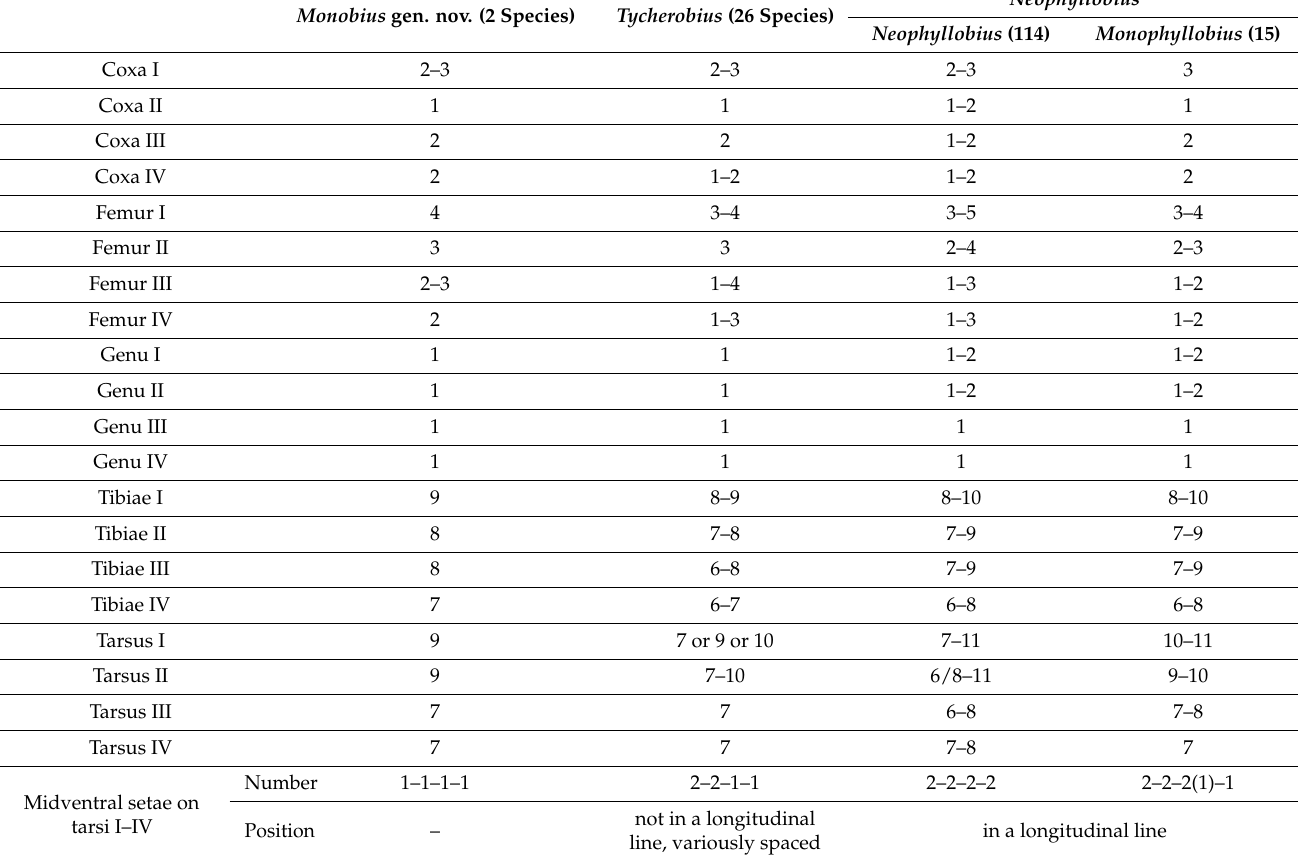
Table 1. Morphological characters (excluding solenidion) of the three genera (after Fan &